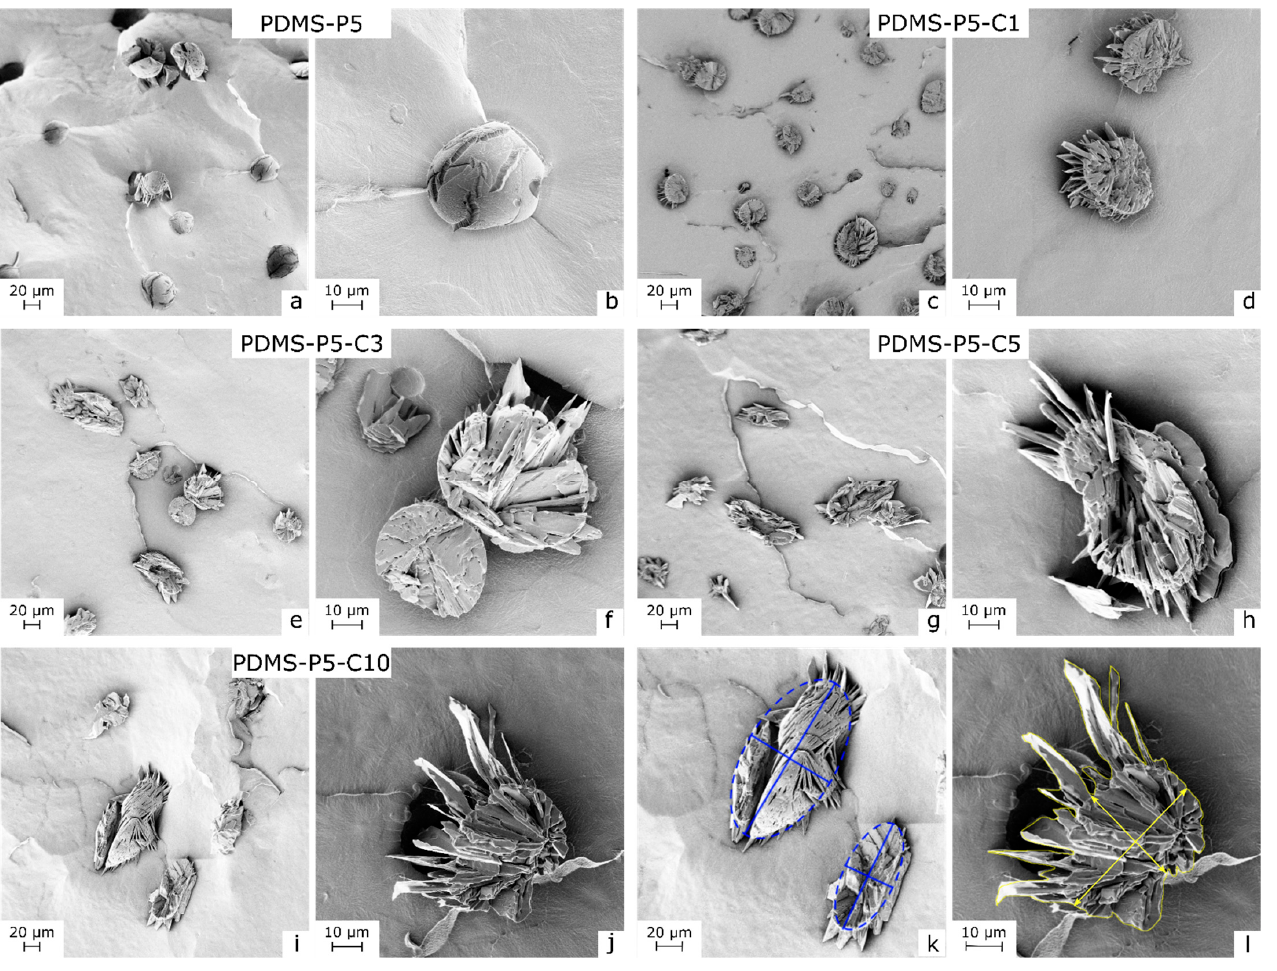
Figure 3. SEM micrographs of the cryofracture surface of some selected bulk samples, at two magnifications. ( a , b ) PDMS-P5; ( c , d ) PDMS-P5-C1; ( e , f ) PDMS-P5-C3; ( g , h ) PDMS-P5-C5; ( i , j ) PDMS-P5-C10; ( k ) sample PDMS-P5-C10, with ellipses for the evaluation of the aspect ratio of paraffin domains; ( l ) sample PDMS-P5-C10, with indications of the inscribed ellipsis and total perimeter for the evaluation of the harpooning coefficient.